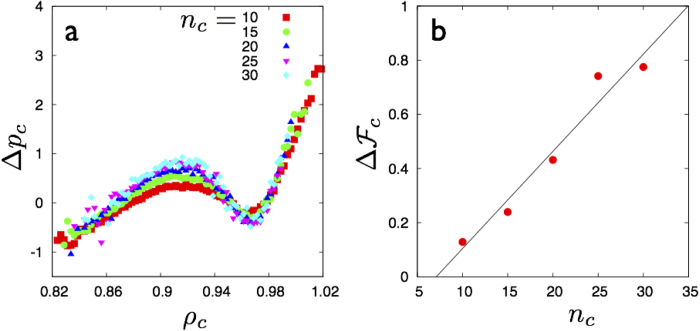
a Plot showing Δpc as a function of the local density ρc for “non-affine” droplets in the strain free LJ solid at T = 0.4. The different colors show the van der Waals loop for various sizes of clusters 10 < nc < 30. The data becomes sparse for much higher values of nc, leading to worse statistics. The van der Waals loops however show stabilisation with larger nc. We have made this quantitative by obtaining an effective barrier height ∆c for this transition by integrating the pressure difference Δpc along ρc for each of these curves. The result is plotted in b and shows that ∆c increases with nc as expected of a first order transition. The solid line is a linear fit.